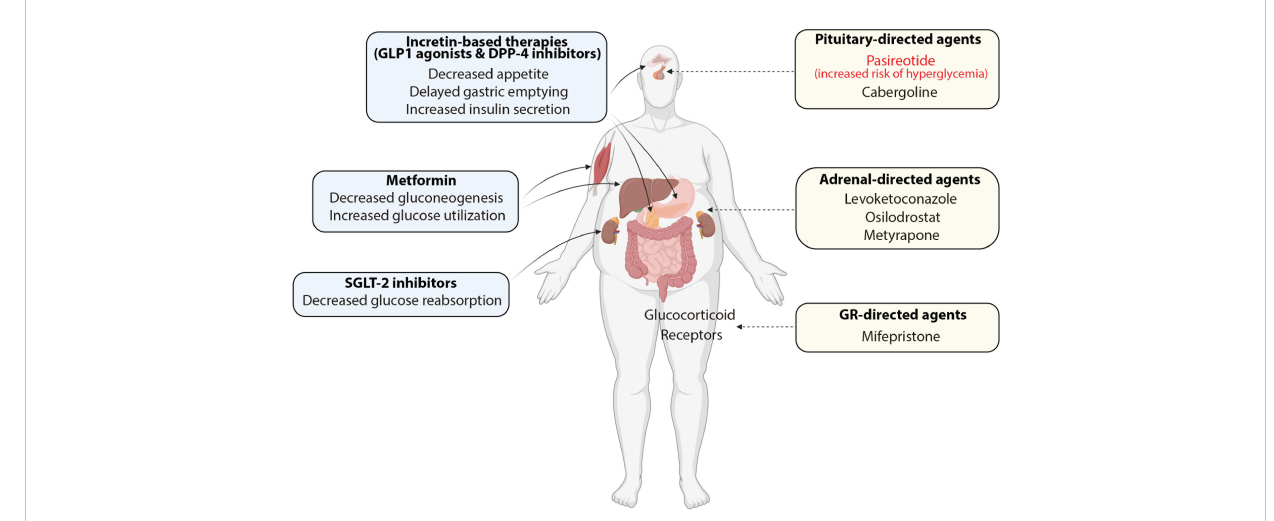
FIGURE 2 Combinations of antidiabetic medications (blue boxes) and cortisol-lowering agents (yellow boxes) in the treatment of patients with Cushing ’ s disease and concurrent diabetes